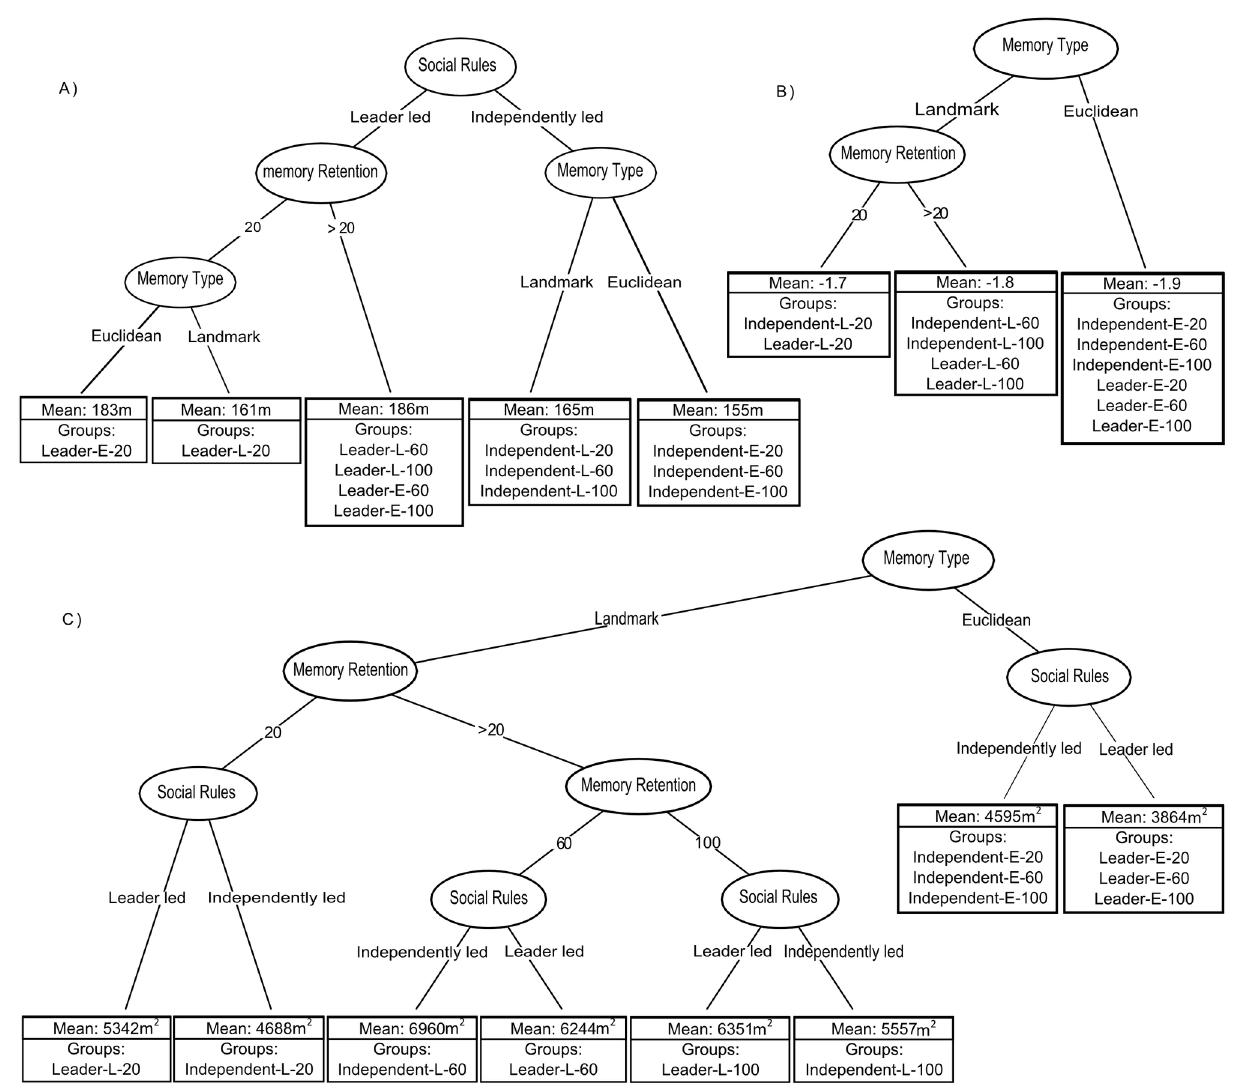
Figure 4. Conditional regression trees of a) daily step length, b) path tortuosity, and c) group spread, using group social rules, memory type, and memory retention as explanatory